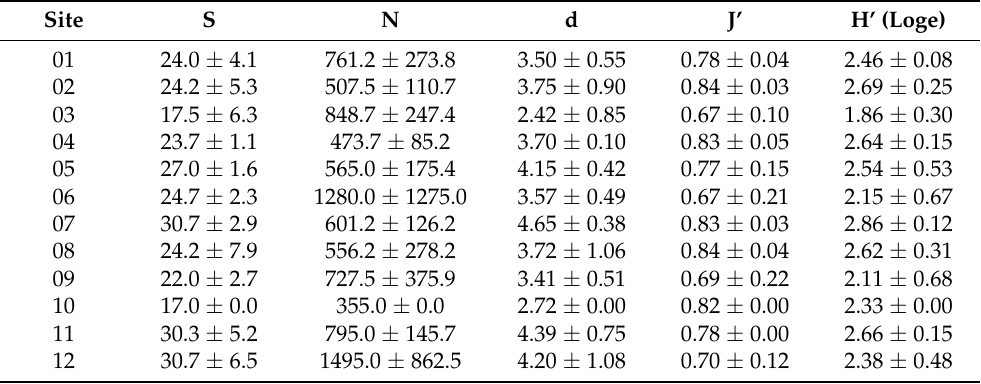
Table 4. Ecological indices of polycheate densities (ind. m − 2 ) (S, number of species; N, total density; d, Margalef’s index; J’, Pielou’s evenness index; H’, Shannon–Wiener diversity index).